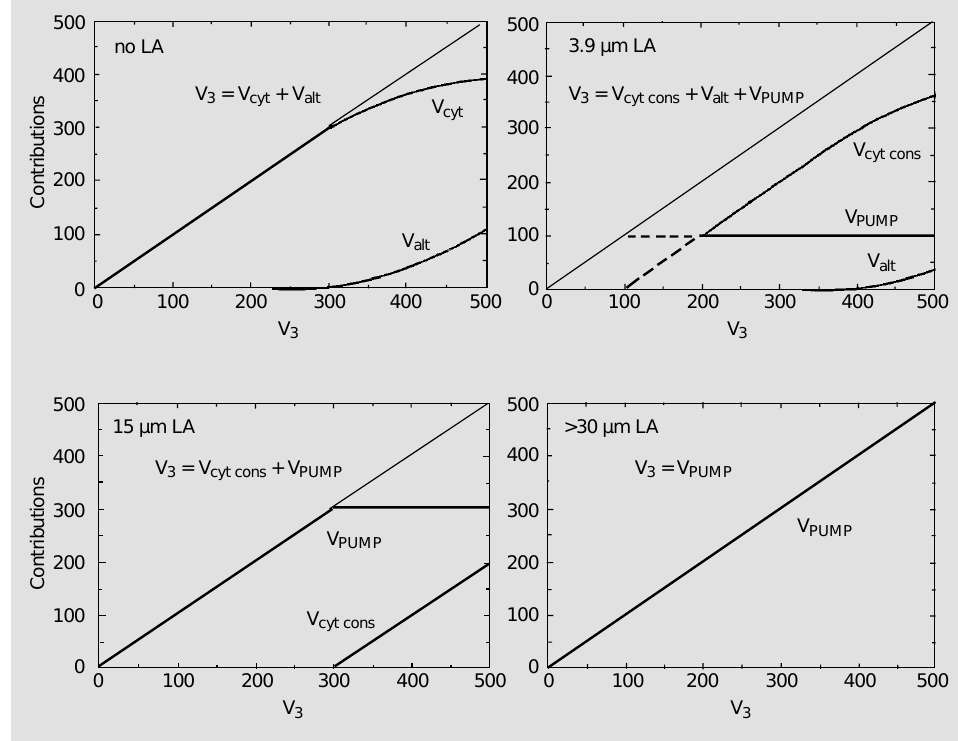
Figure 9 - Contributions of the three pathways (V cyt , V PUMP , and V alt ) to overall state 3 respi- ration. For details see